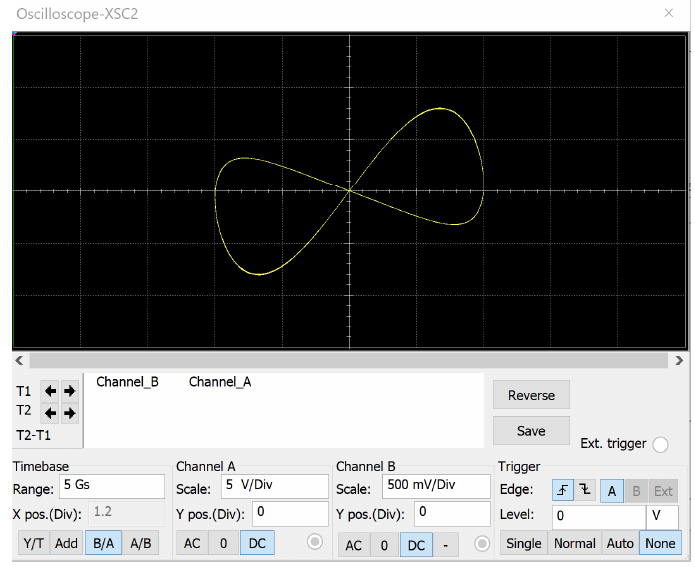
Figure 5. 𝑣 (cid:3014) − 𝑖 (cid:3014) characteristics of the realized circuit of the fractional-order memristor.